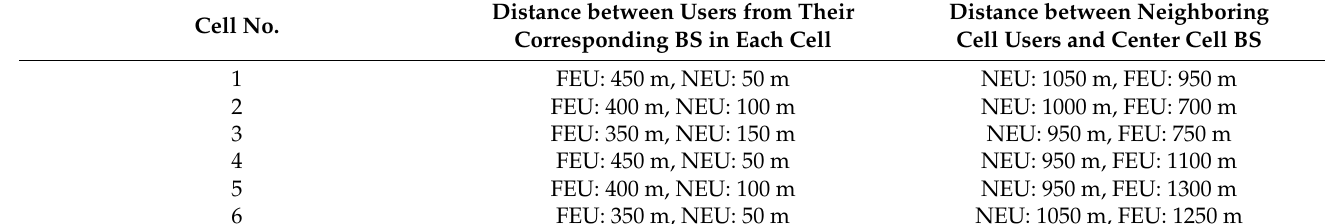
Table 3. System Parameters for 7-cell Scenario. Cell No.